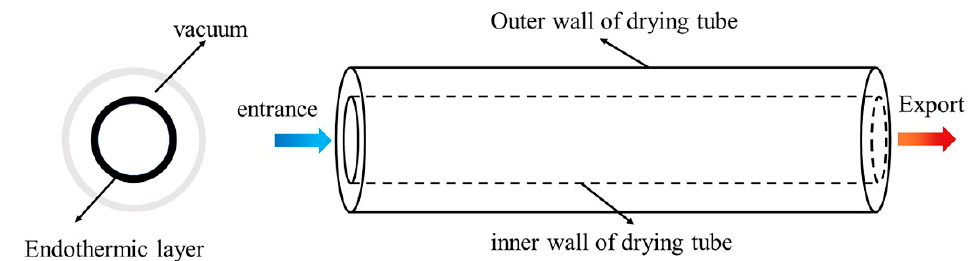
Figure 3. Schematic diagram of circulating solar collector tube. 4. Flash tank: The flash tank is 0.8 m in diameter and 1.6 m in height. Its internal and the gas–liquid separation efficiency is increased through turbulent